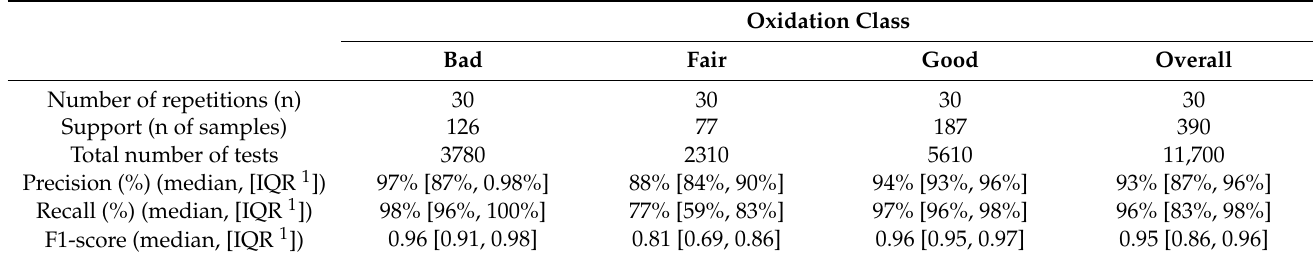
Table 2. Convolutional neural network test performances by oxidation